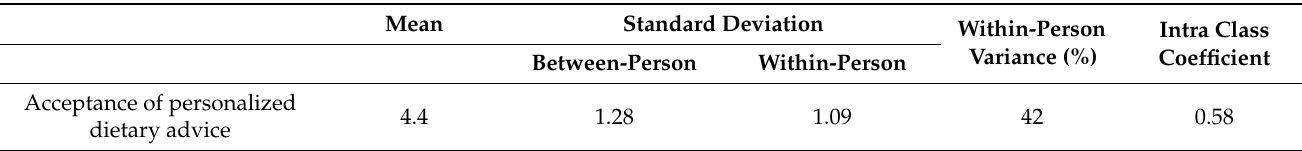
Table 2. The mean and variance components displayed as standard deviations for acceptance of personalized dietary advice.